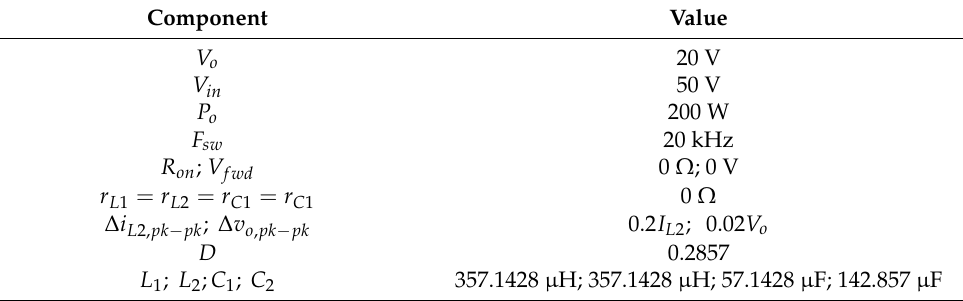
Table 7. Sepic converter